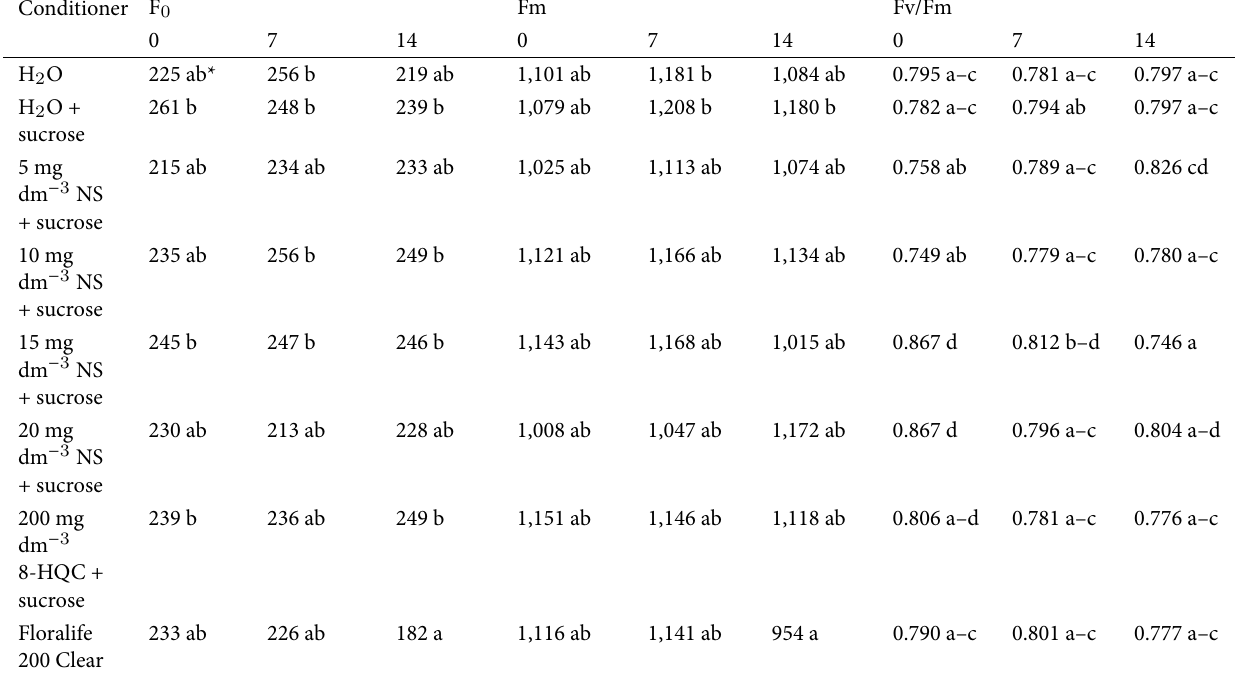
Table 3 Effect of conditioning on minimal fluorescence (F 0 ), maximal fluorescence (Fm), and maximal quantum efficiency of PSII (Fv/Fm) in leaves of Thalictrum aguilegifolium after 0, 7, and 14 days holding time in water after the 24-hr postharvest treatment. Means from